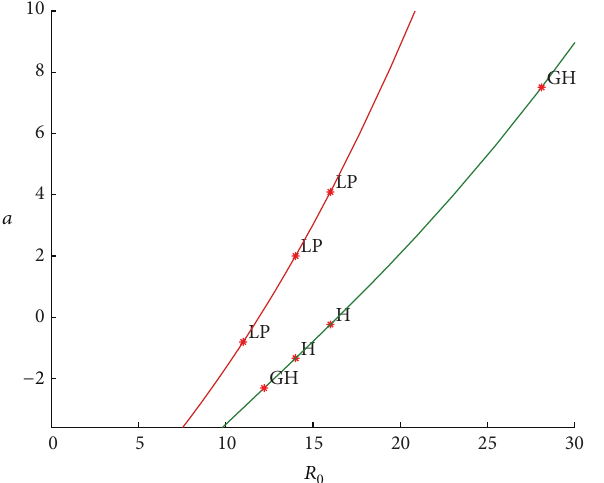
Figure 5: Bifurcation figure when 𝑅 0 and 𝑎 are taken as bifurcation parametersinsystem(3)byfixed 𝐴 = 2, 𝑑 = 0.1, 𝛽 = 0.8, 𝑏 = 2.4, 𝜖 = 0.6, 𝛾 = 0.2